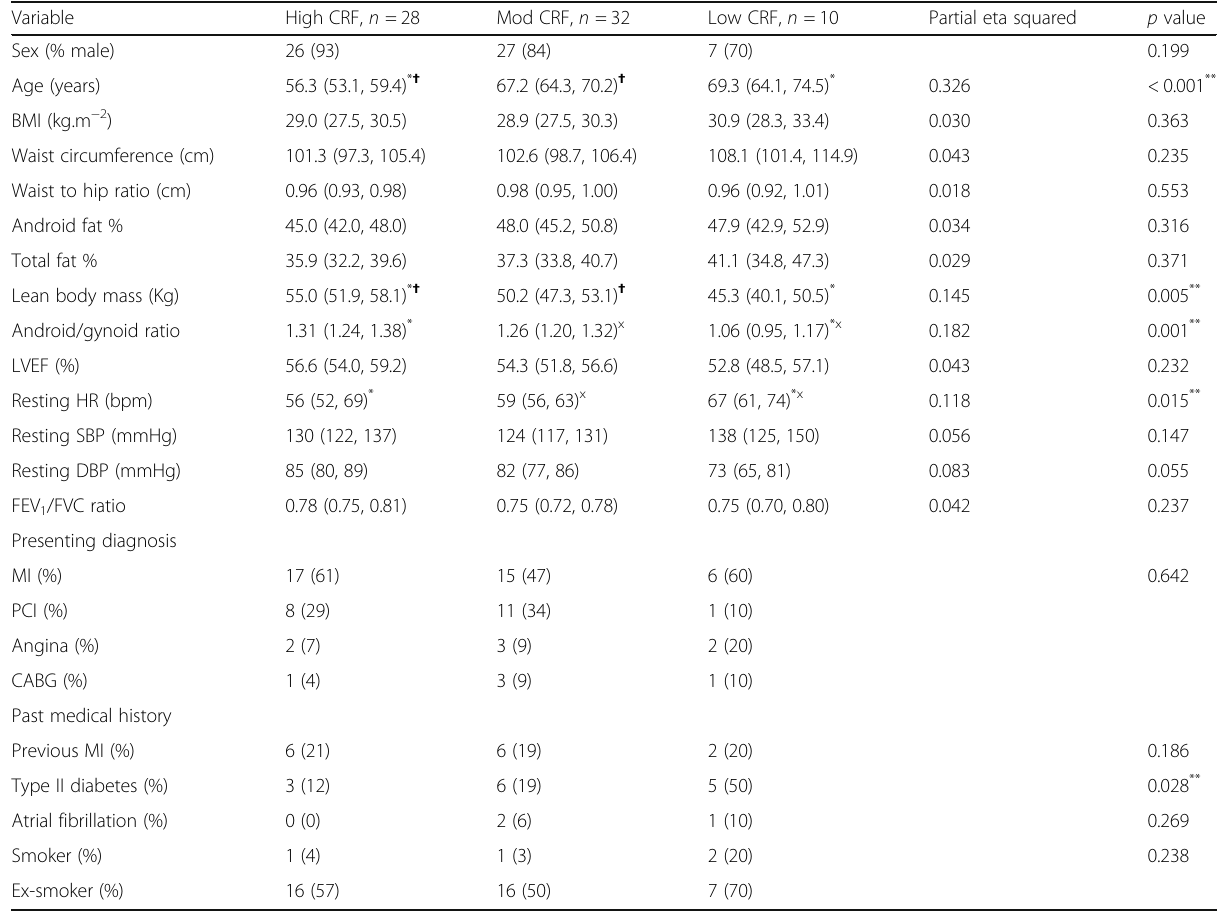
Table 2 Patient Characteristics Expressed as Mean (95% Confidence Intervals)